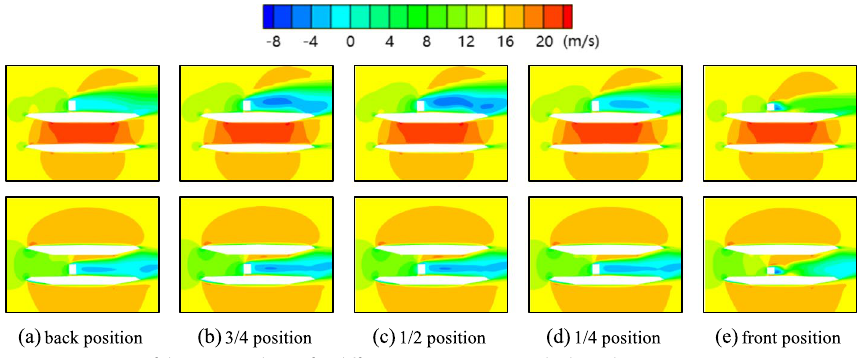
Fig. 19 Counters of the mean velocity for different cross sections (vehicle on lane